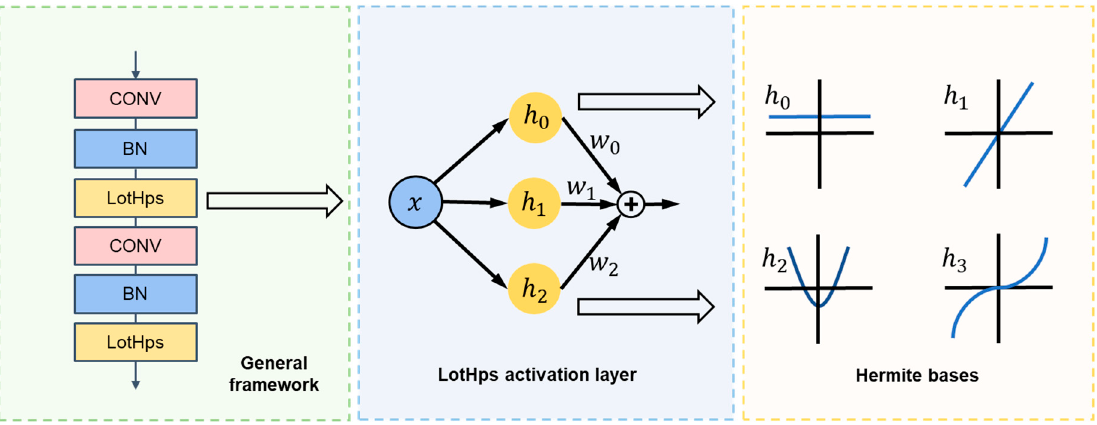
Figure 2. Low-degree Hermite neural network (LHDNN)